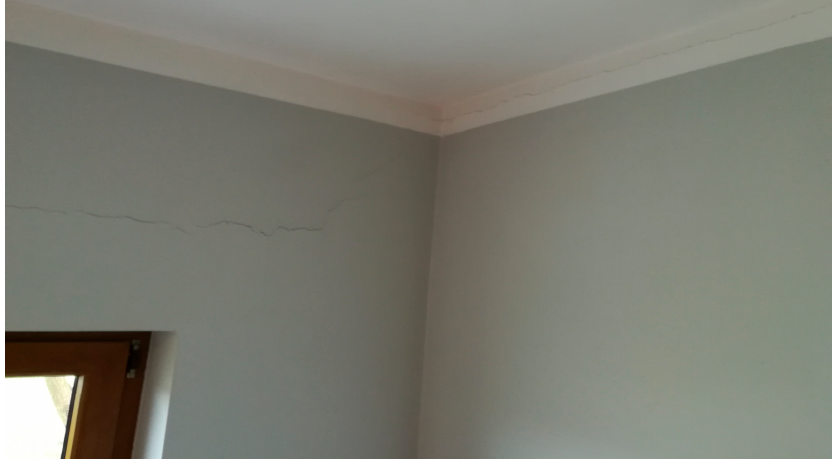
Figure 20. An example of a crack was created as a result of uneven settlement of the building (at the window and under the ceiling).